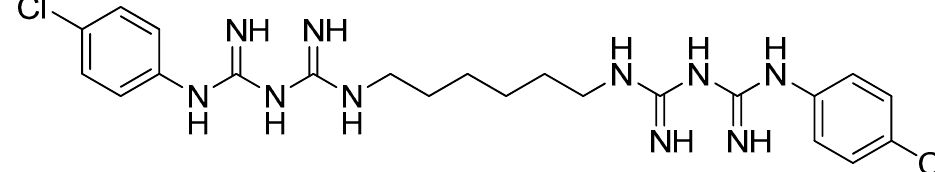
Figure 2. Structural formula of chlorhexidine gluconate.